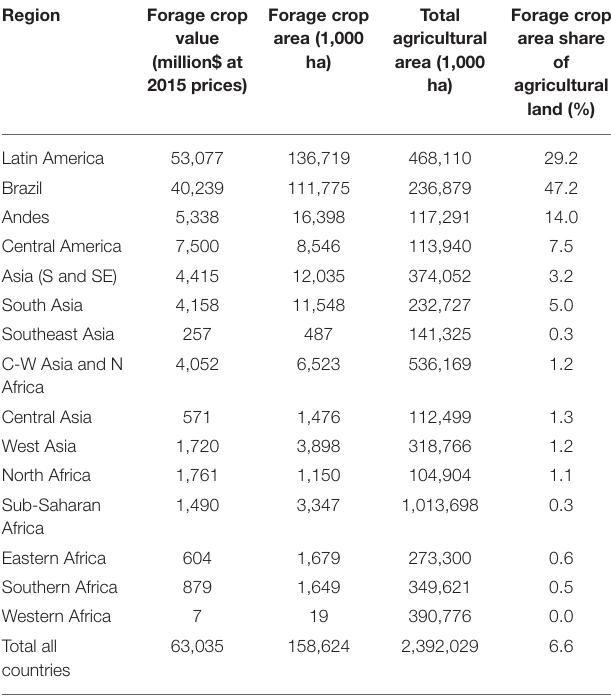
TABLE 3 | Extent and value of tropical forage crops in developing countries.